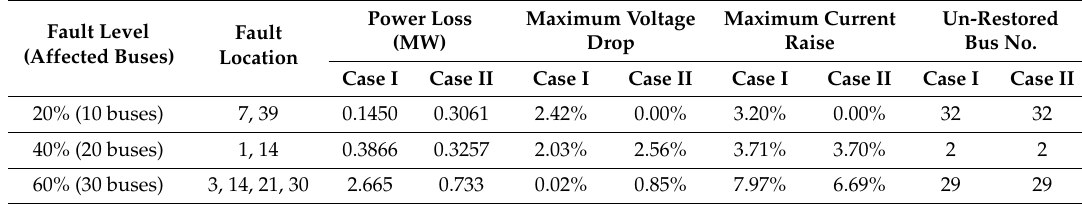
Table 3. Performance of restoration under faults at multiple buses.